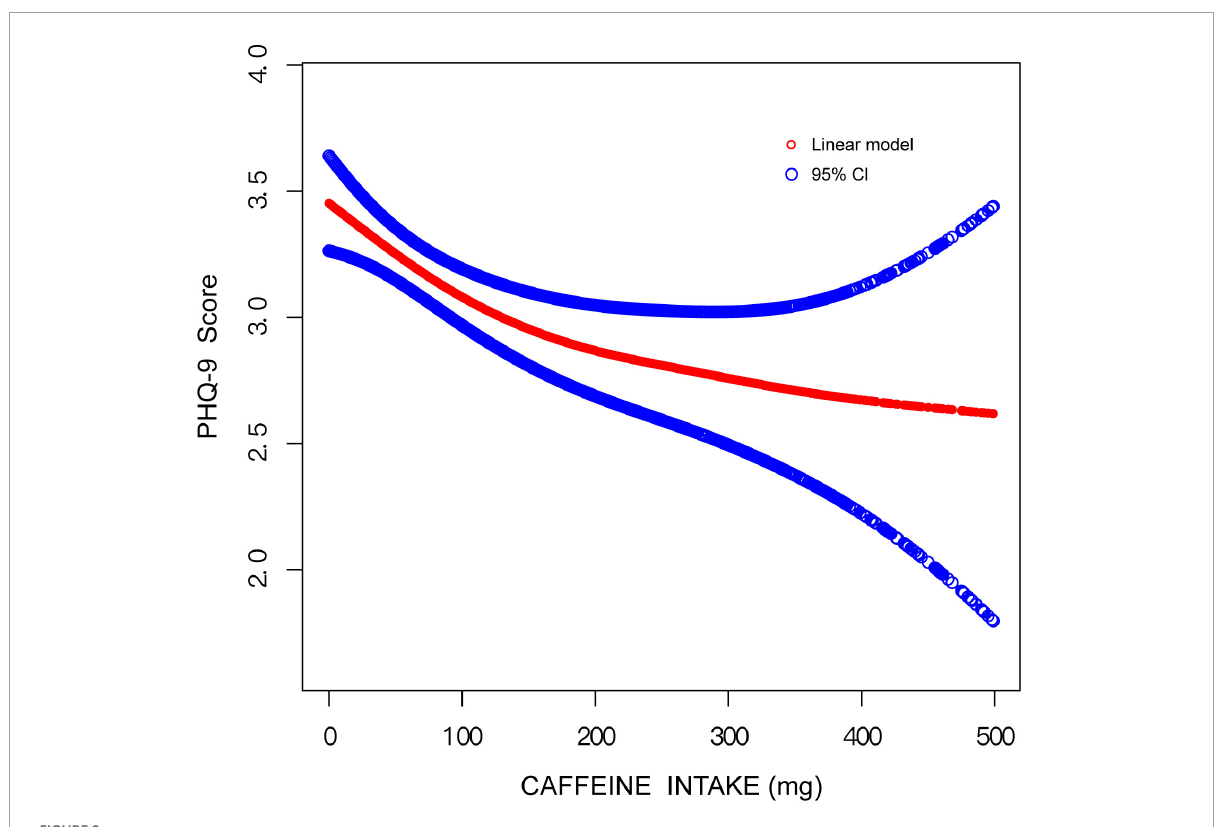
FIGURE2 Curve fitting model on the association between caffeine intake and